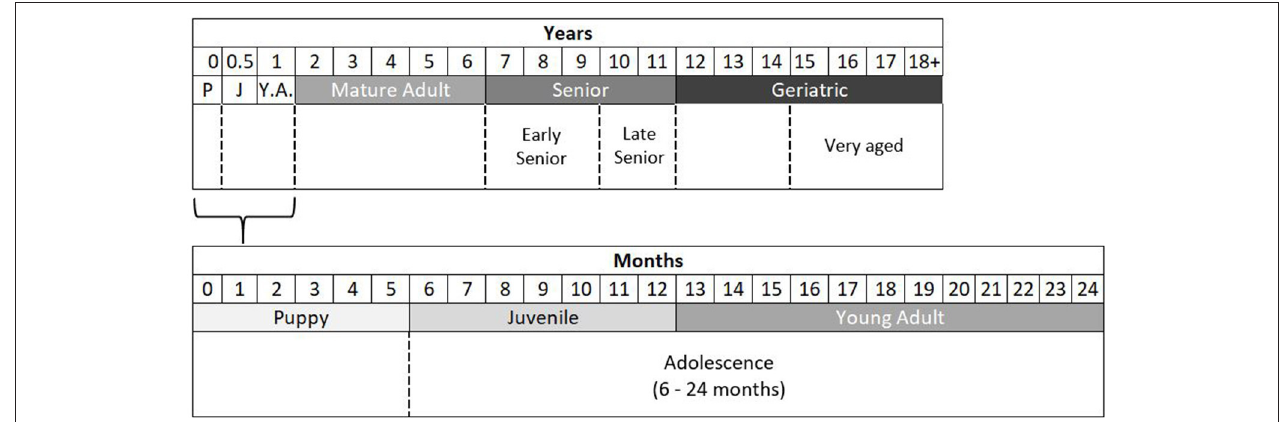
FIGURE 2 | Normative and developmental stage thresholds for categorizing the domestic dog into age groups. Shown in dashed lines on the bottom rows are optional broader/finer level groupings. P, puppy; J, juvenile; Y.A, young